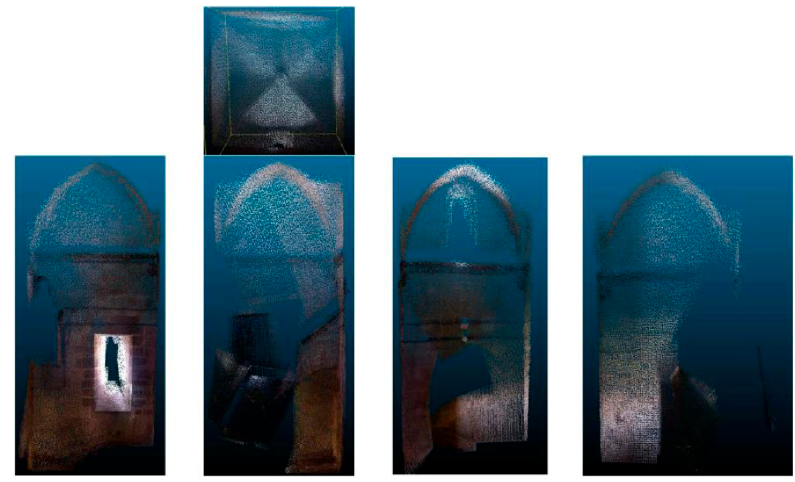
Figure 12. Point clouds obtained in the first experiment: different sections and ceiling.